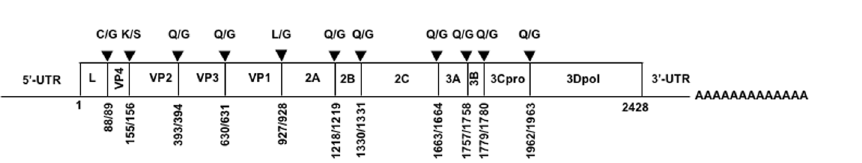
Figure 2. Genome organization of the SSV Cam13 strain. The genome organization and aa sequences of the putative cleavage sites of the polyprotein of Cam13 are